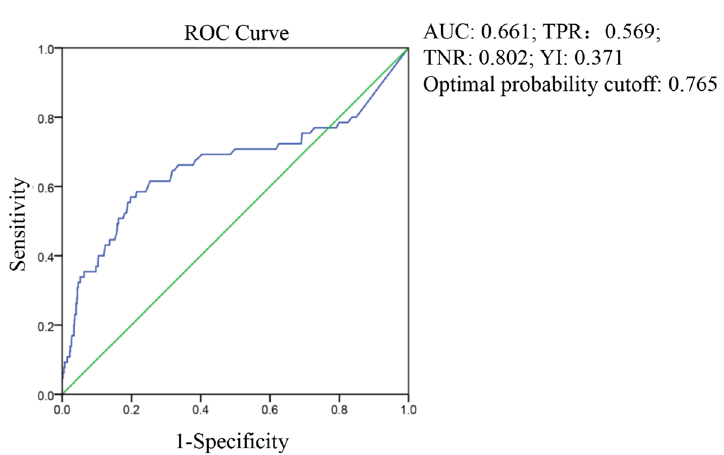
Figure 1. ROC curve of D-dimer from the first test, in predicting hospital discharge and mortality.